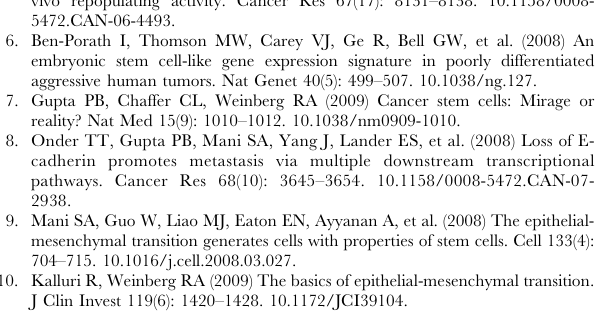
Table S4 Gene Ontology Annotation for Gene Expression Clusters 1–12. Only the most significant enrichment factors and false discovery rates (FDR) are shown.